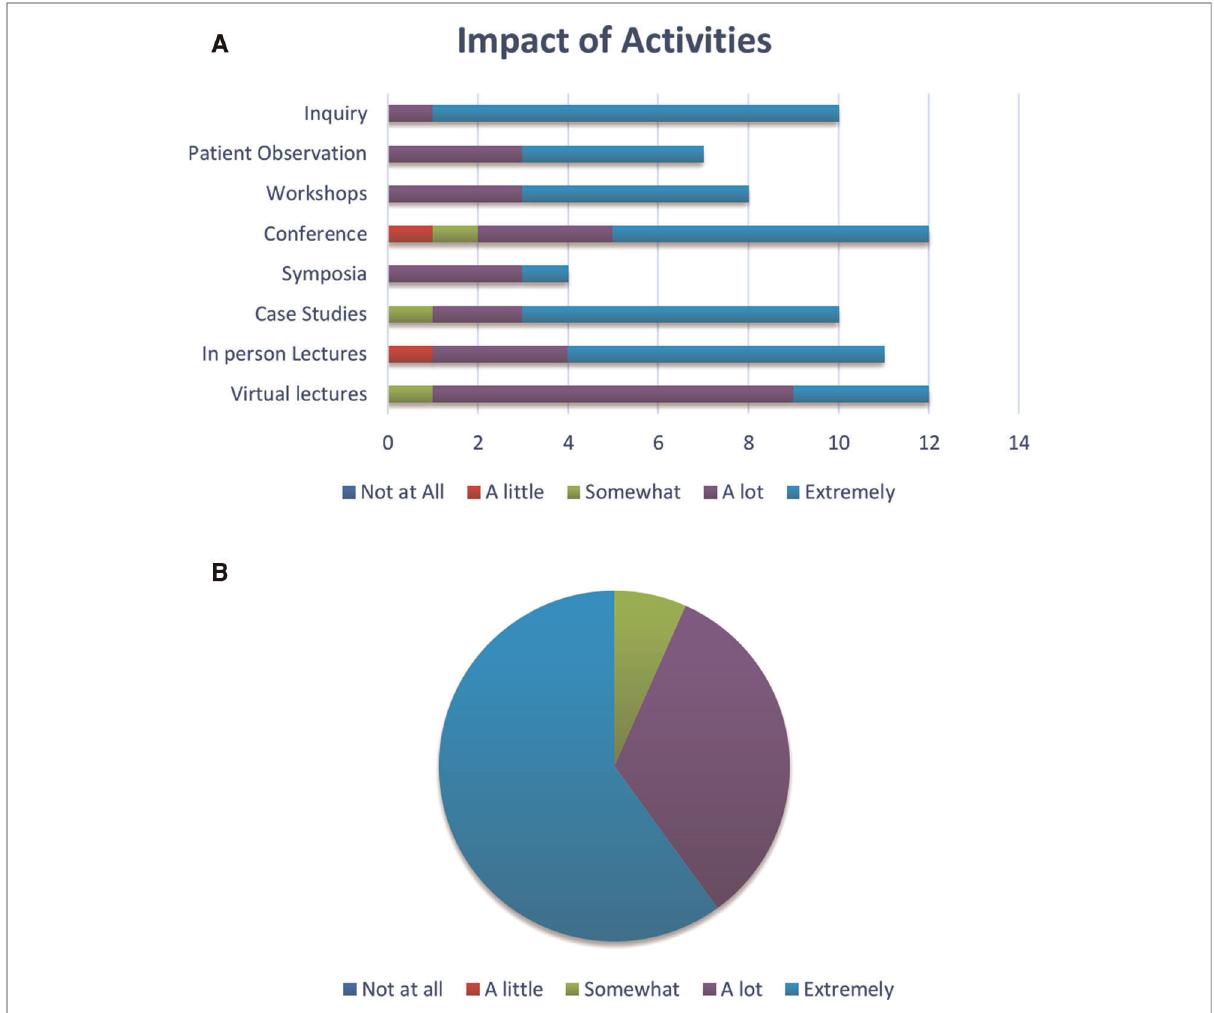
FIGURE 2 ( A ) Impact of activities on providers in Egypt. X axis is the number of physicians attending each activity. ( B ) Self-reported impact on clinical practice after participating in learning